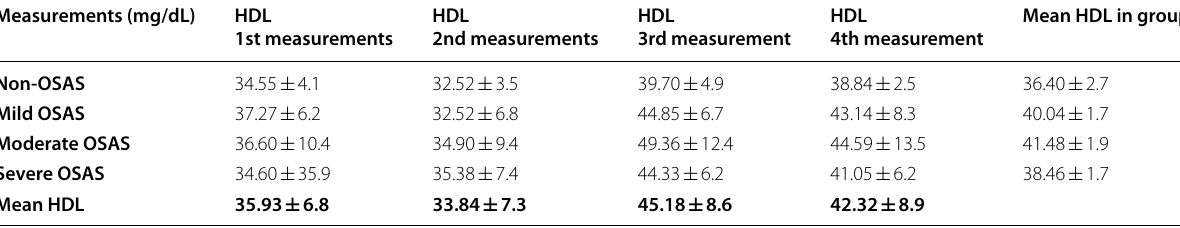
Table 3 Comparison of the HDL levels between the groups